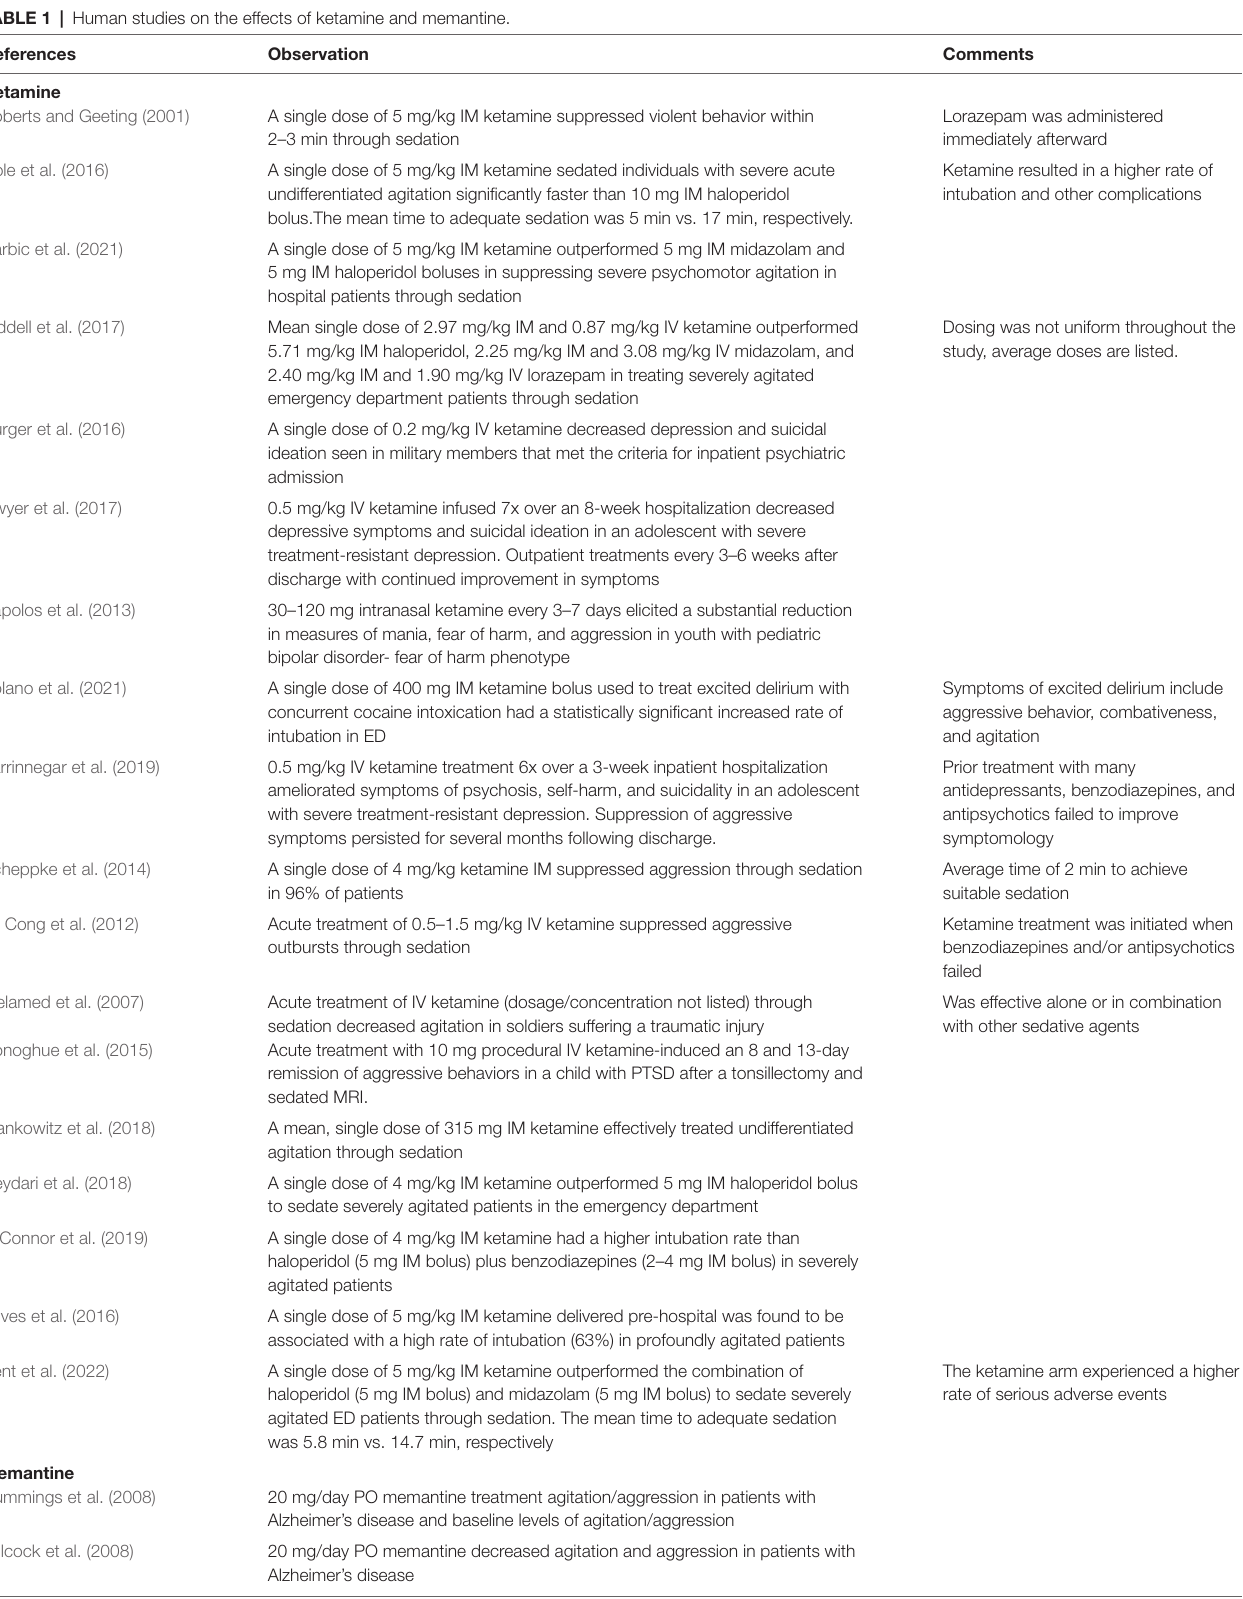
TABLE 1 | Human studies on the effects of ketamine and